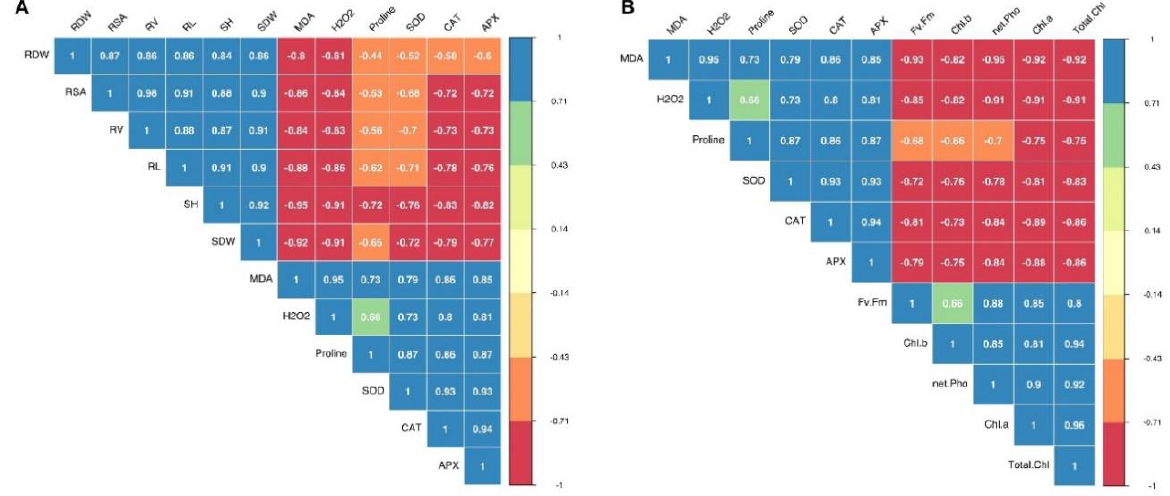
Figure 6. The Pearson’s correlation matrixes showing association between the different parameters in silage corn genotypes when grown at low temperatures. Correlation matrix between morphological and biochemical attributes of silage corn ( A ); correlation matrix between silage corn photosynthetic and biochemical parameters ( B ). APX: ascorbate peroxidase; CAT: catalase; SOD: superoxide dismutase; Chl a : chlorophyll a ; Chl b : chlorophyll b ; H 2 O 2 : hydrogen peroxide; MDA: malondialdehyde; RDW: root dry weight; RL: root length; RSA: root surface area; RV: root volume; SDW: shoot dry weight; SH: seedling height; total Chl: total chlorophyll.